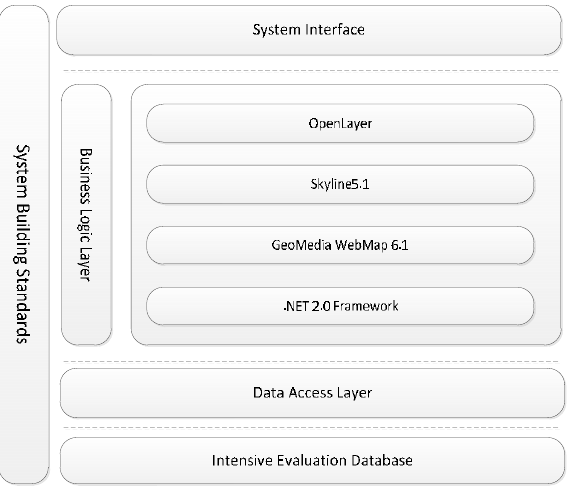
Figure 2. System architecture diagram